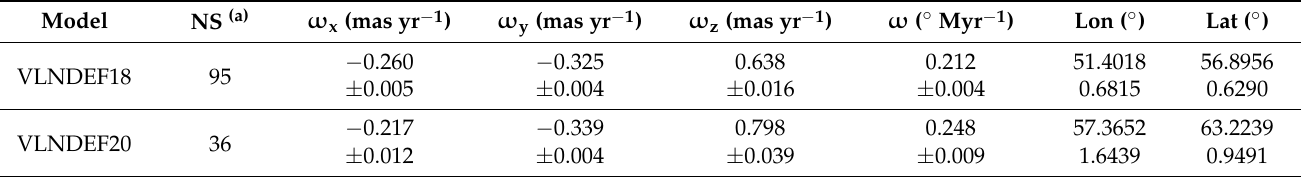
Table 1. Rotational and geographic coordinates of the Euler poles (“mas yr − 1 ”= milliarcsecond/yr; “ ◦ Myr − 1 ” = degree/ Millions yr). VLNDEF18 from Zanutta et al. [14]; VLNDEF20 in this work. Model